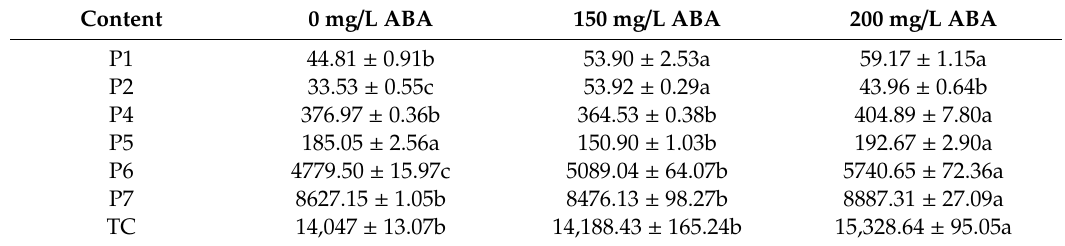
Figure 1. HPLC chromatograms of carotenoid pigments extracted from petals of ‘Yanhonggui’. P1: phytoene. P2: lutein. P3: internal standard β-apo-8′-carotenol. P4: unidentified carotenoid. P5: β-cryptoxanthin. P6: α-carotene. P7: β-carotene. Table 2. Carotenoid content in the petals of ‘Yanhonggui’ receiving ABA treatments.